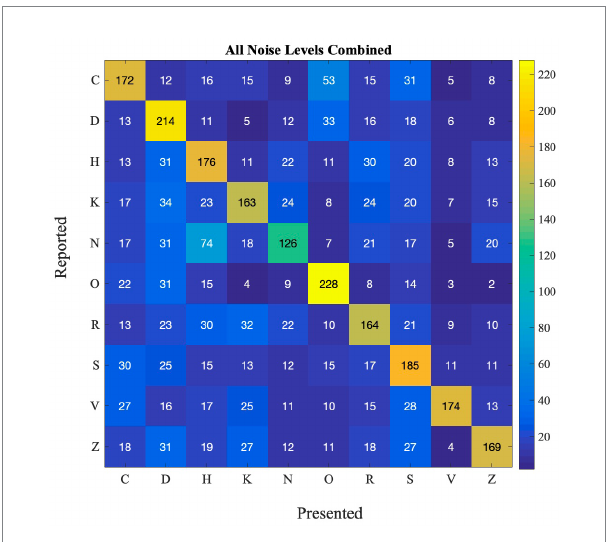
FIGURE 3 Confusion matrix depicting the frequency of reported and presented letters in Experiment